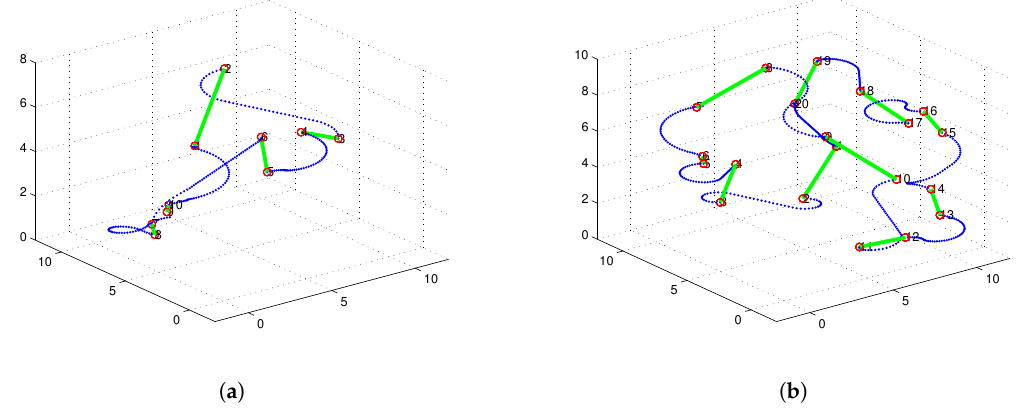
Figure 9. The 3D Alternating Algorithm (AA-3DTSP) with one AUV. ( a ) with 10 targets; ( b ) with 20